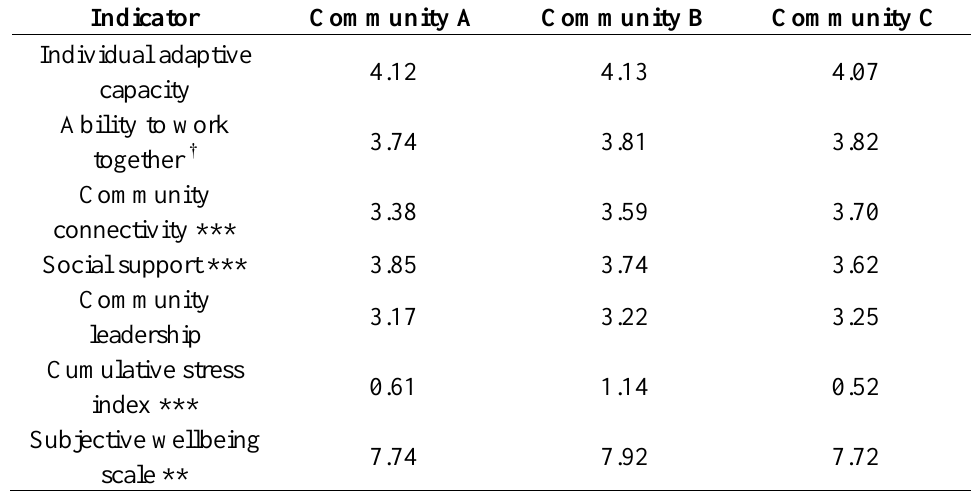
Table 3. Benchmarking outcomes by